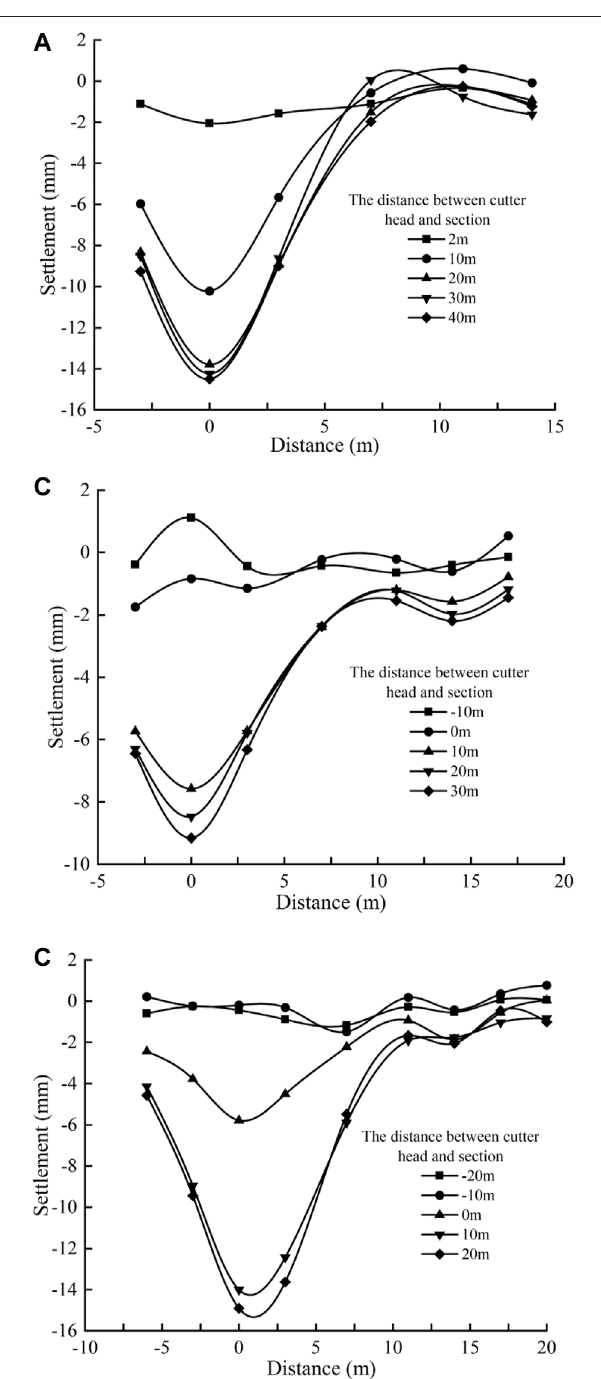
FIGURE 6 | Surface settlement curves of the three sections: (A) D1, (B) D2, and (C) D3.